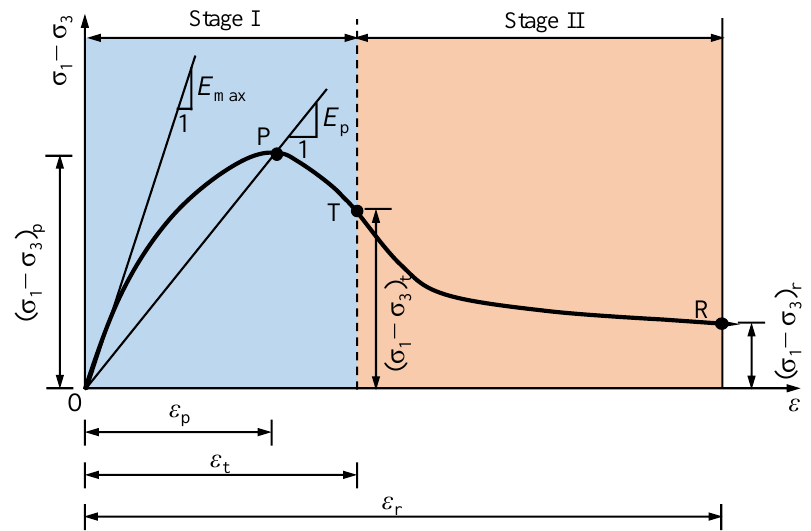
Figure 8. Schematic diagram of a nonlinear constitutive model for the remoulded fine-grained materials. (1) Coefficient determination for Equation